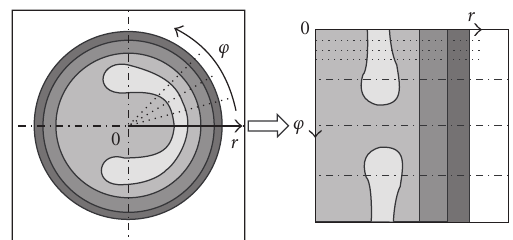
Figure 4: Schematic illustration of the coordinate transformation performed before phase